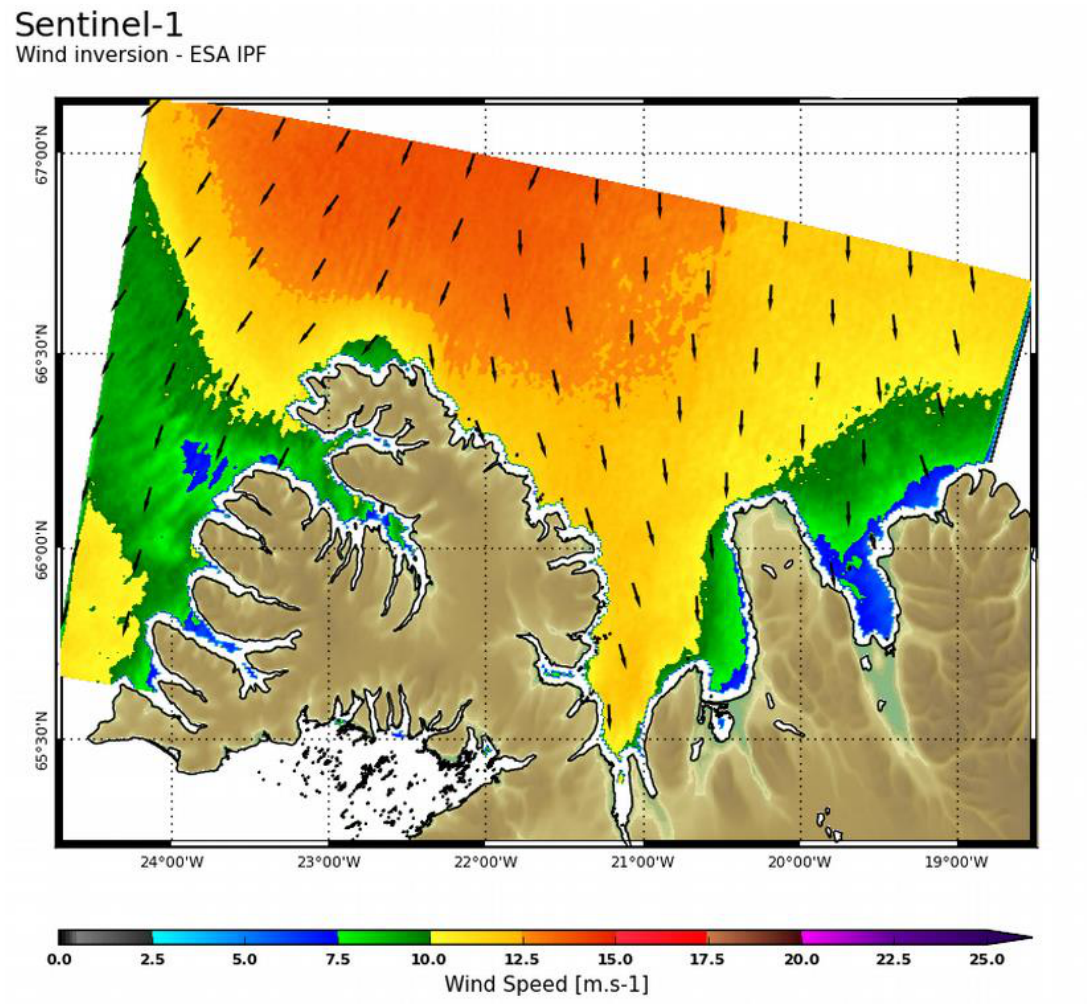
Figure 4. Coastal wind product around Denmark derived from Sentinel 1-A (mode IWS, polarization VV) acquired on 19 July 2015. Copernicus Sentinel data